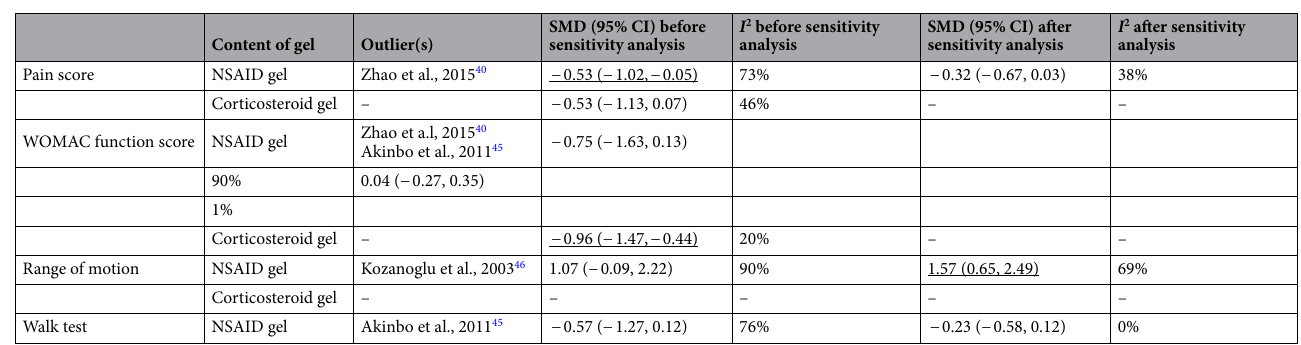
Table 2. Sensitivity analysis. Significant results are underlined. WOMAC, the Western Ontario and McMaster Universities Arthritis Index; SMD, standard mean difference; CI, confidence